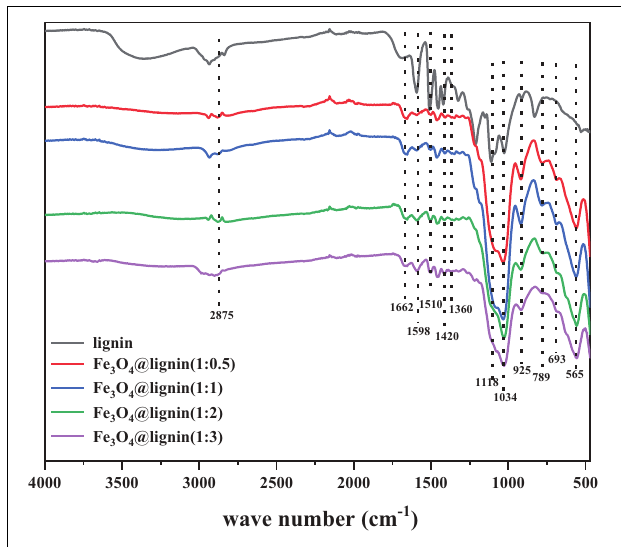
FIGURE 5 | Infrared spectroscopy of magnetic lignin nanoparticles.